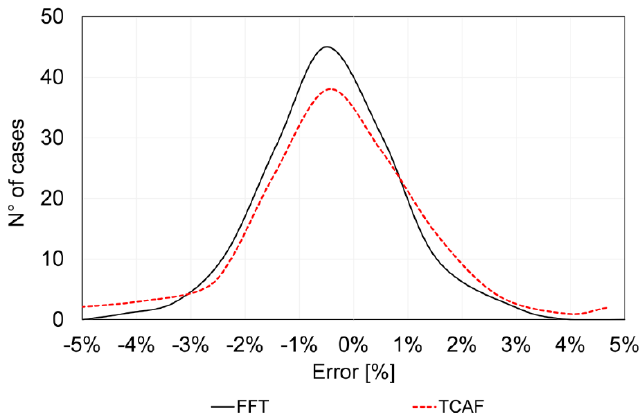
Figure 17. Gaussian distribution of errors in the evaluation of the injected fuel at medium–low speed and different engine loads: comparison between the TCAF and the FFT